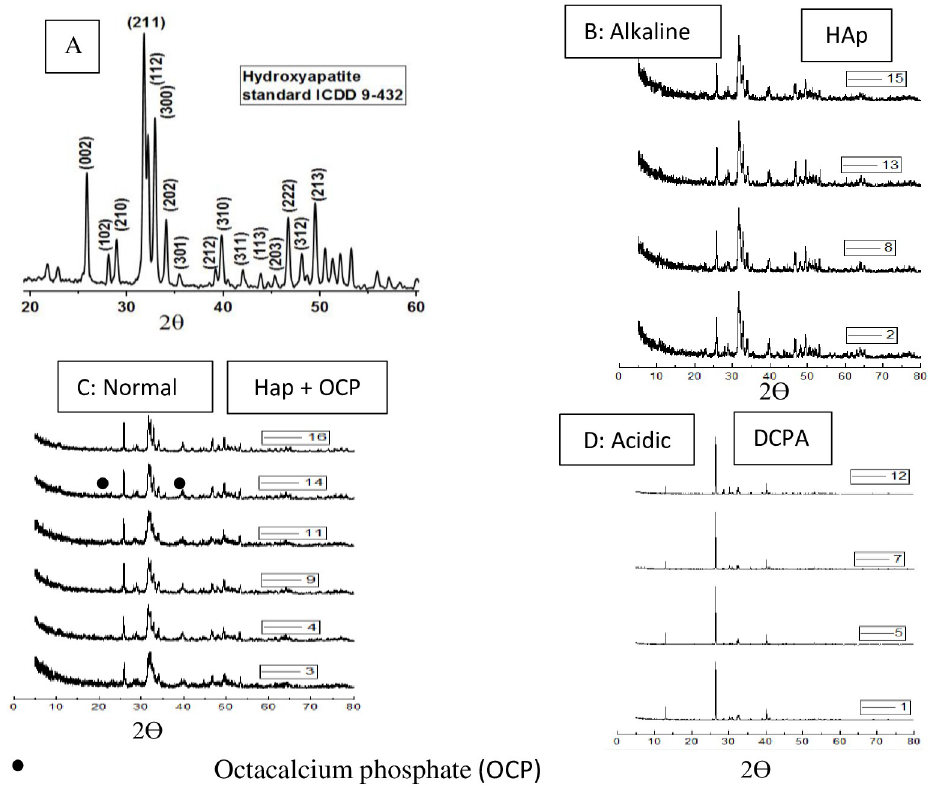
Fig 5. XRD pattern hydroxyapatite standard [29] and XRD pattern at different condition based on RSM design.